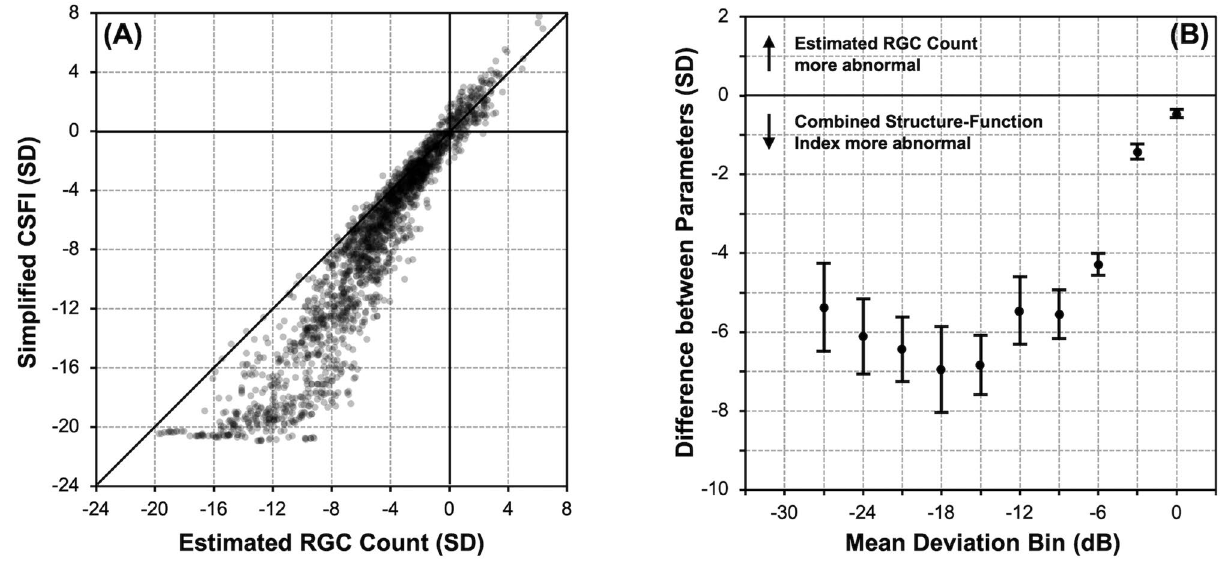
Figure 1. ( A ) Scatterplot of the Z-scores (standard deviations [SD] away from the normal cohort) of the simplified combined structure–function index (sCSFI) against the estimated retinal ganglion cell (RGC) count for the eyes with glaucoma. ( B ) The difference in Z-scores between the sCSFI and estimated RGC count across visual field mean deviation bins (including at least 100 samples), illustrating how the sCSFI captures a significantly greater magnitude of abnormality (or deviation from normal) than the estimated RGC for all bins (P < superior compared to the eRGC parameter ( P = 0.001). Similar findings of a better performance of the eRGC count and sCSFI parameters for discriminating all glaucoma eyes and early glaucoma eyes (MD ≥ − 6 dB) from healthy eyes compared to average RNFL thickness and MD were observed ( P ≤ 0.007). The sCSFI also simi- larly performed better than the eRGC parameter for discriminating all glaucoma eyes and early glaucoma eyes ( P ≤ 0.009).